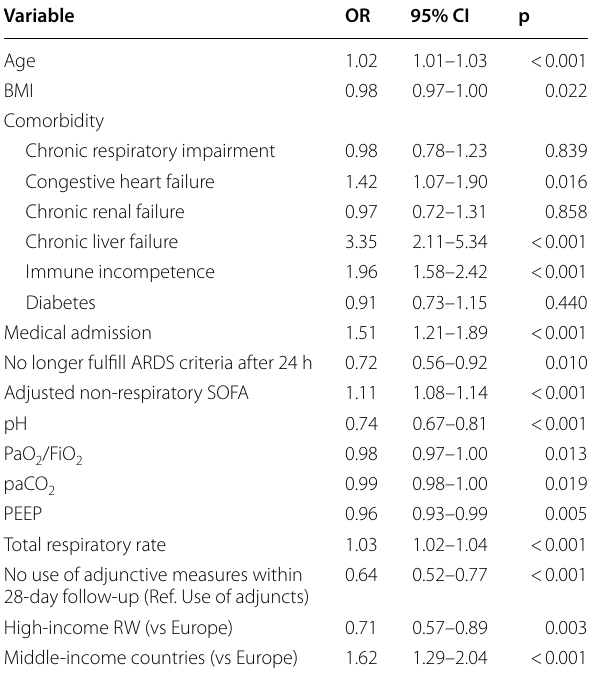
associated with the ICU mortality in all